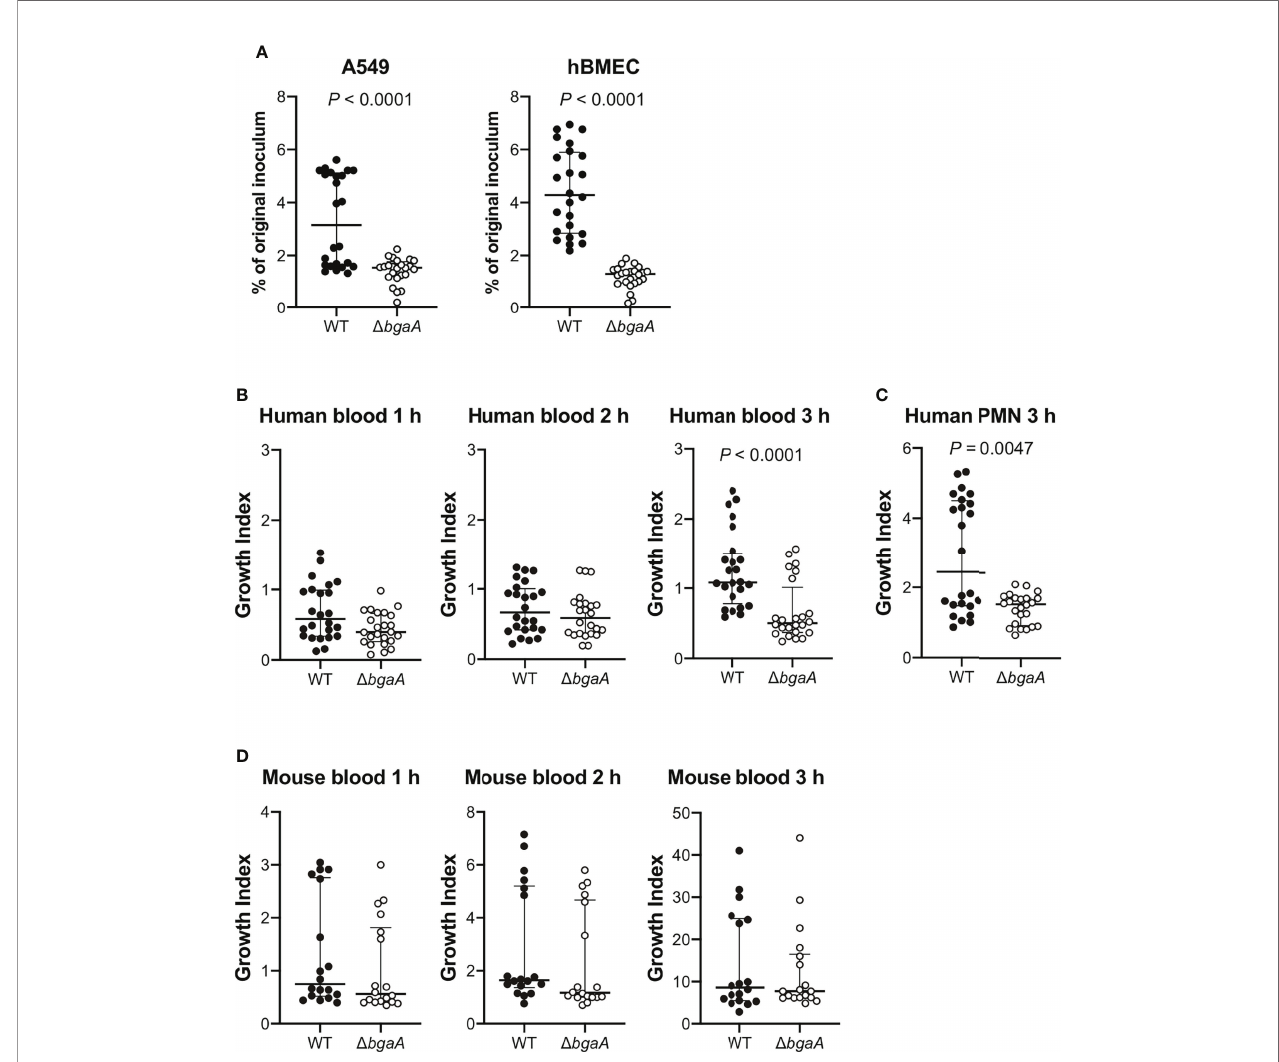
FIGURE 1 | De fi ciency of bgaA decreases pneumococcal association with human epithelial and endothelial cells and survival after incubation with human neutrophils. (A) Rate of association with A549 cells and hBMECs by S. pneumoniae TIGR4 wild type and D bgaA strains. Association rates were calculated by dividing the CFU value obtained at one hour after infection by the value for the original inoculum. (B) Growth index of S. pneumoniae WT and D bgaA strains in human blood. Bacterial cells were incubated in human blood for one, two, and three hours at 37°C. (C) Growth index of S. pneumoniae WT and D bgaA strains with human neutrophils. Bacterial cells were incubated with human neutrophils for 3 h at 37°C. (D) Growth index of S. pneumoniae WT and D bgaA strains in mouse blood. Bacterial cells were incubated in mouse blood for one, two, and three hours at 37°C. (B – D) After incubation, samples were serially diluted and plated on TS blood agar. The number of CFUs was determined following incubation. Growth index was calculated by dividing the CFU after incubation by the CFU of the original inoculum. The median and interquartile range (IQR) are represented using horizontal and vertical lines. Differences between groups were analyzed using Mann – Whitney U -test. The data were pooled from three or four independent experiments. Individual values are provided in Supplementary Data 1 Supplementary Figure 1 ). At 36 h after infection, WT and were no signi fi cant up- or down-regulated pathways at 12 h D bgaA- infected mice shared 165 upregulated and 6 post-infection ( Figure 4C ). Expression pro fi les of TNF- a signaling-related genes at 24 and 36 h after infection were downregulated genes compared with PBS-treated mice. WT- visualized on a KEGG pathway diagram ( Supplementary infected mice presented upregulated 234 genes and Figure 2 ). Genes encoding cytokines and chemokines, including TNF- a , CCL-2/MCP-1, and so on, were down- ( Figure 4B and Supplementary Figure 1 ). Pathway analysis of regulated in WT-infected mice compared with D bgaA- infected the differentially expressed genes revealed that several signaling mice, while the expression of TNF- a signaling-related genes was pathways associated with host innate immunity were not so largely changed. In addition, Reactome pathway analysis signi fi cantly downregulated in WT-infected mice compared indicated that WT-infected mice presented signi fi cantly with D bgaA- infected mice at 24 h and 36 h, whereas there